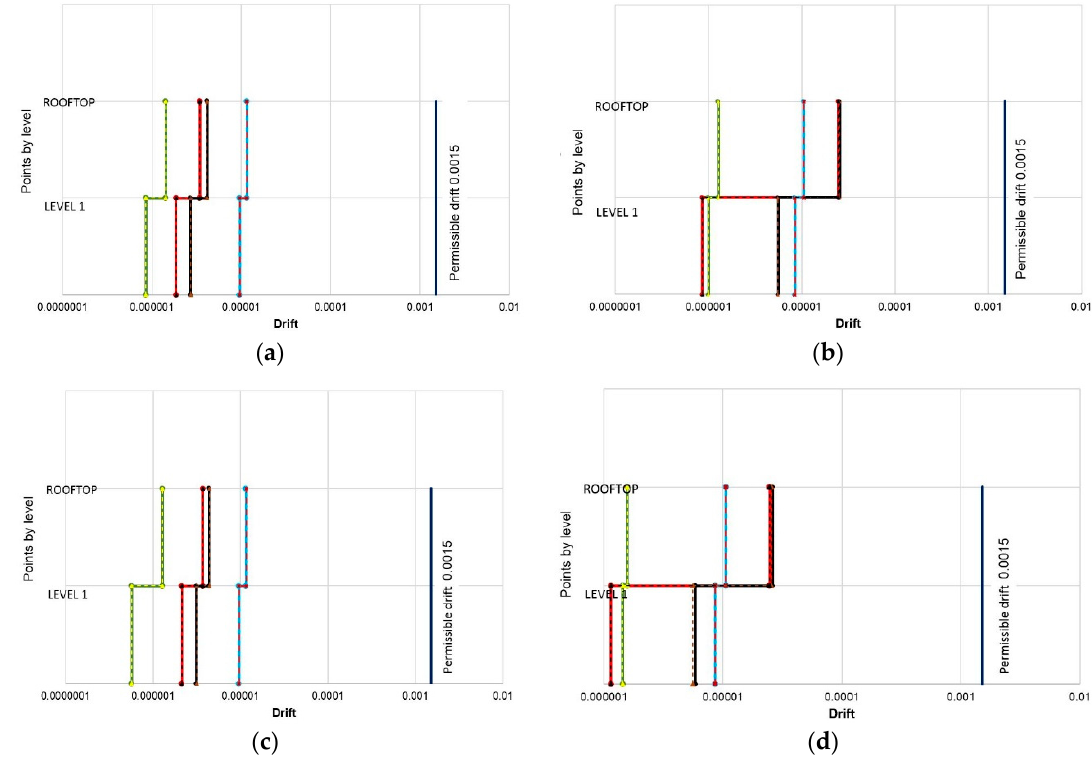
Figure 12. Seismic combination 100%Sx + 30%Sy: ( a ) direction x, ( b ) direction y; seismic combination 30%Sx + 100%Sy: ( c ) direction x, ( d ) direction y. Table 8. Base shear forces.